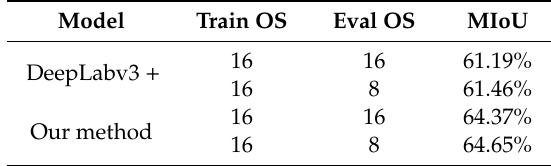
Table 3. Mean Intersection over Union (MIoU) value of the underwater image dataset.